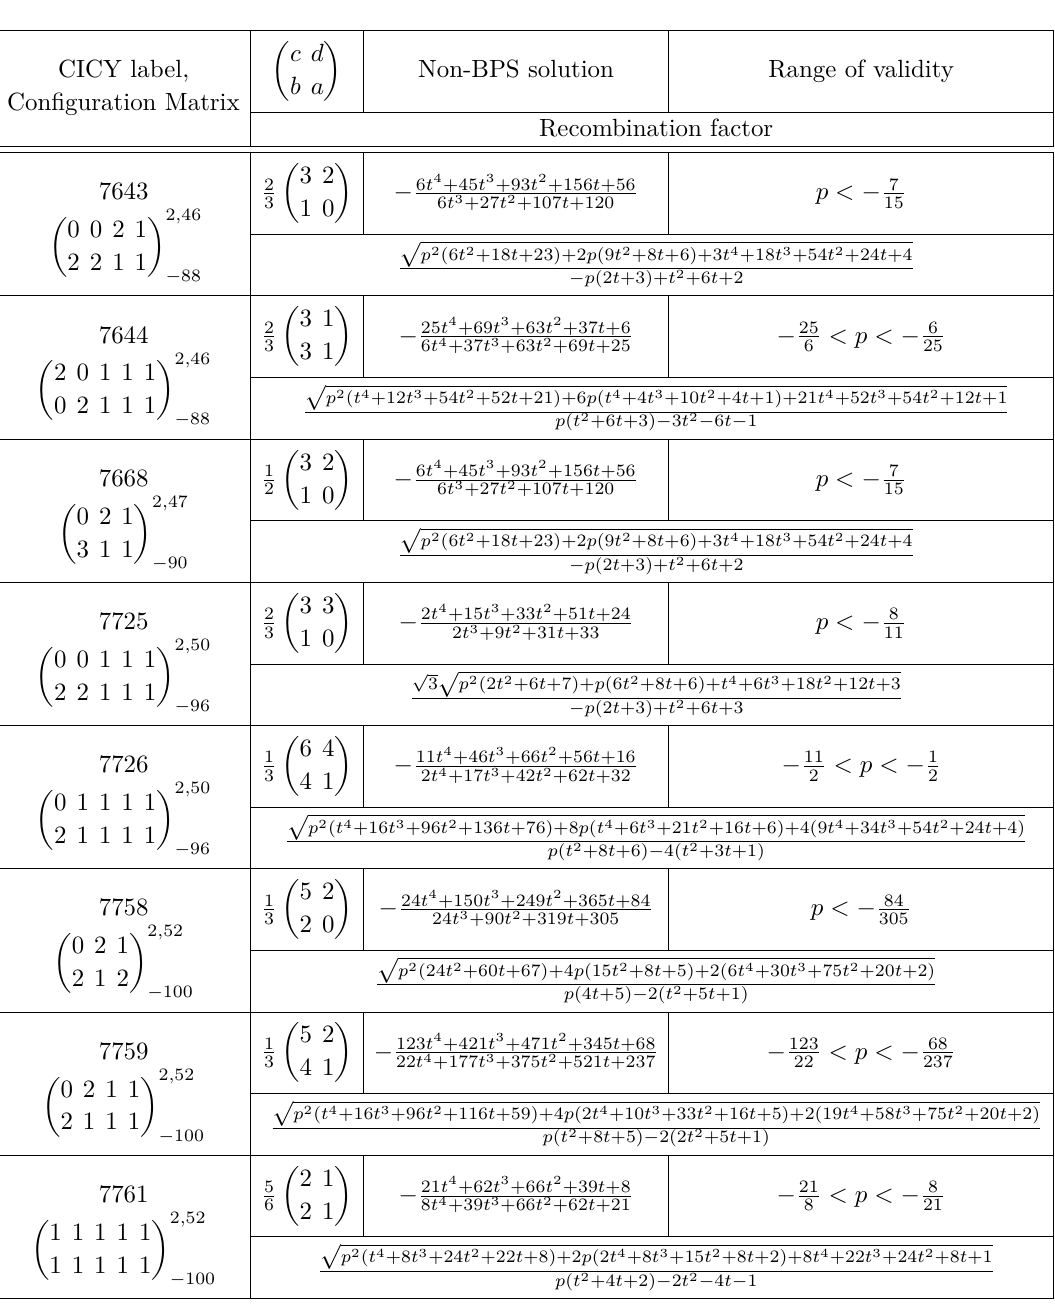
Table 9 . Non-BPS extremal black strings in one-modulus CICY models,